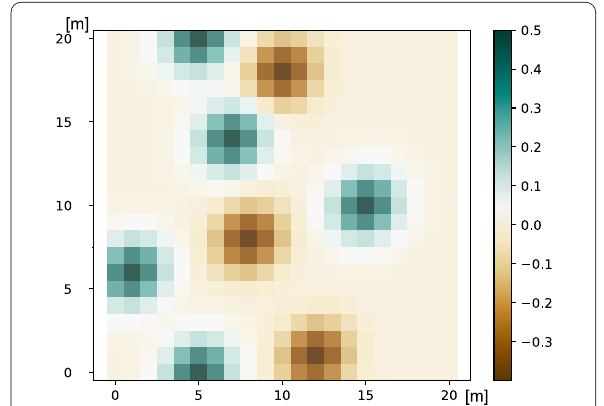
Fig. 3 The artificial terrain. The higher places are colored green, and the lower places are colored